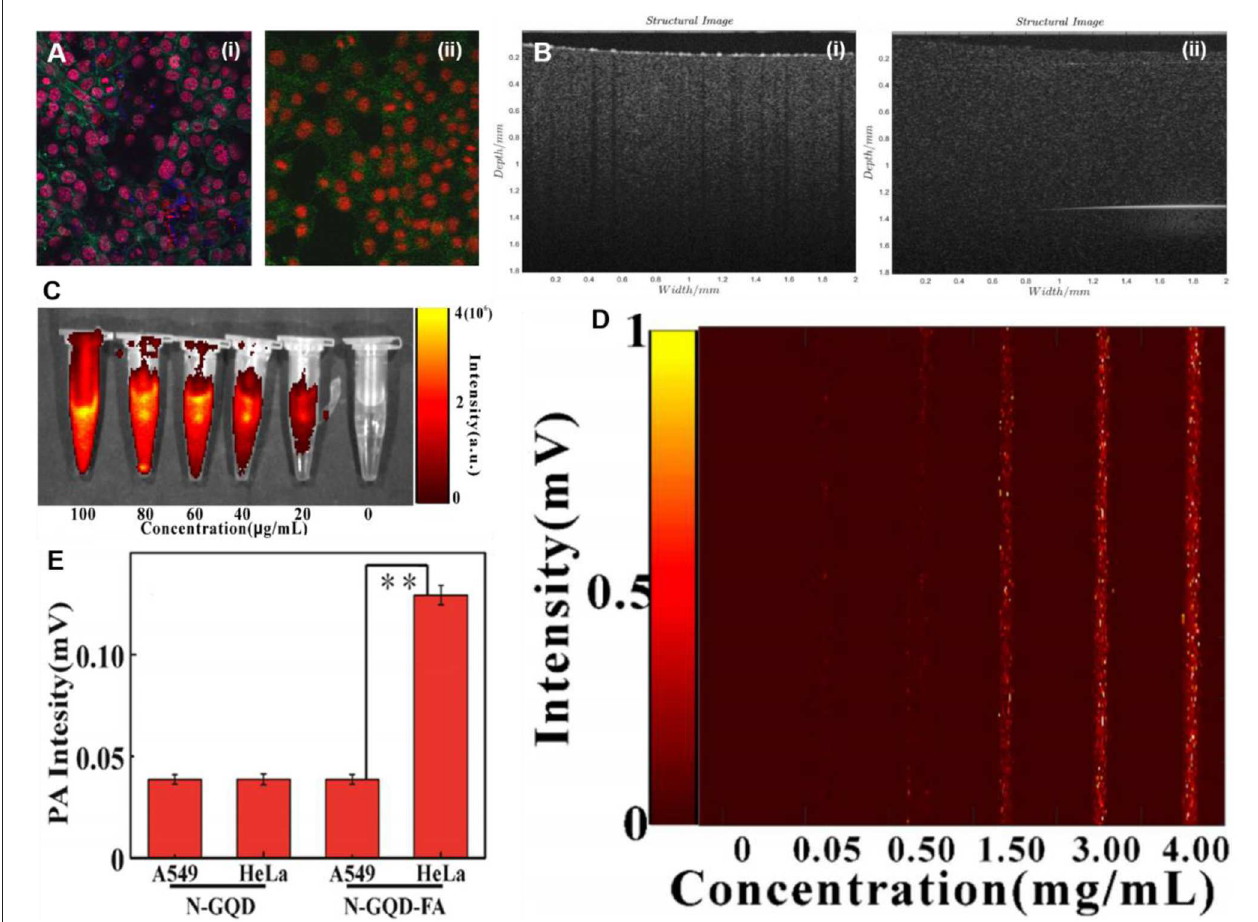
FIGURE 14 | (A) Visible light, confocal microscopic (CLSM) images of superparamagnetic GQDs (MGQDs) labeled (i) and unlabeled (ii) 3T3 cells. (B) magnetomotive optical coherence tomography (OCT) images of MGQDs labeled (i) and unlabeled (ii) 3T3 cells; reproduced from Li et al. (2019) with permission from Wiley. (C,D) Concentration-dependent enhanced near-infrared (NIR) fluorescence as well as photoacoustic imaging (PAI) signal. (E) In Vitro PAI intensity of FA-N-GQDs and N-GQDs in both HeLa cells and A549 cells, respectively; reproduced from Xuan et al. (2018) with permission from IOP Publishing. **means P value is